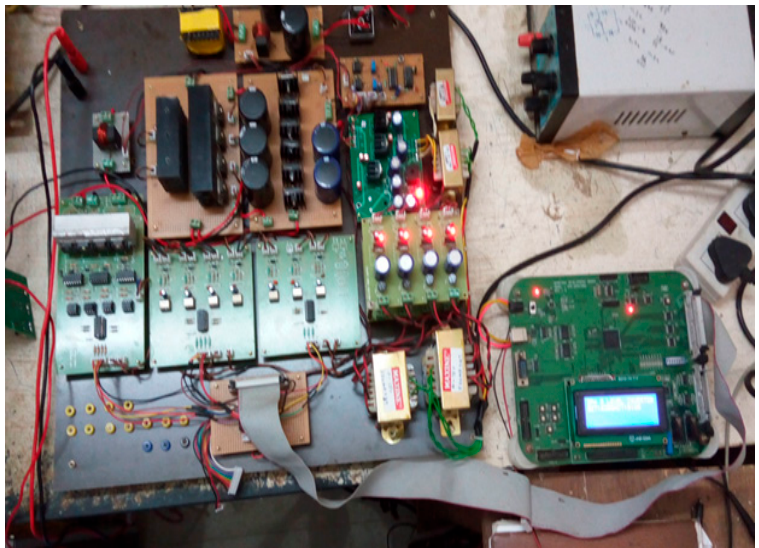
Figure 23. Hardware implementation of the TLBDCLCHB inverter system with an FPGA controller.